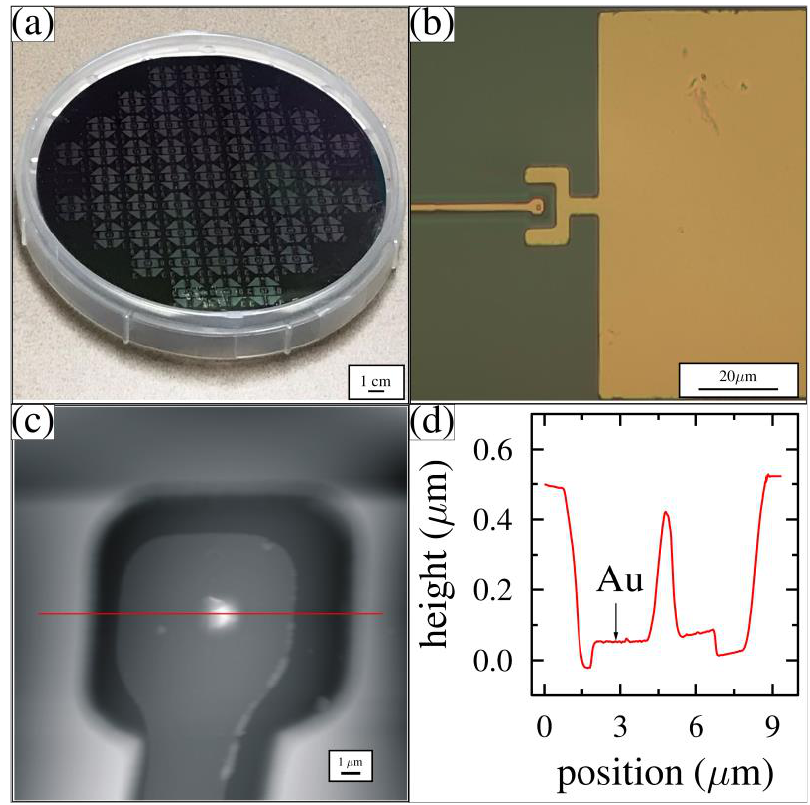
Figure 8. Optical and AFM images. ( a ) Mask 2 patterned full wafer; ( b ) tip-well feature with bonding pad after gold deposition; ( c ) AFM image of a single tip-well structure; and ( d ) horizontal line profile through the tip in ( c ) that reveals the gold thickness.